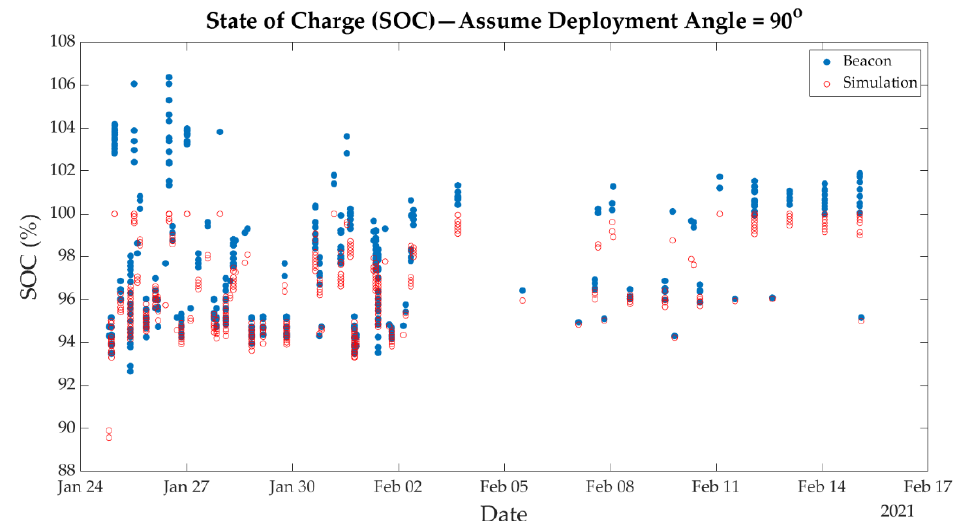
Figure 23. SOC measured on-orbit from beacon data (blue circles) and simulated assuming full panel deployment (red circles) as a function of time.